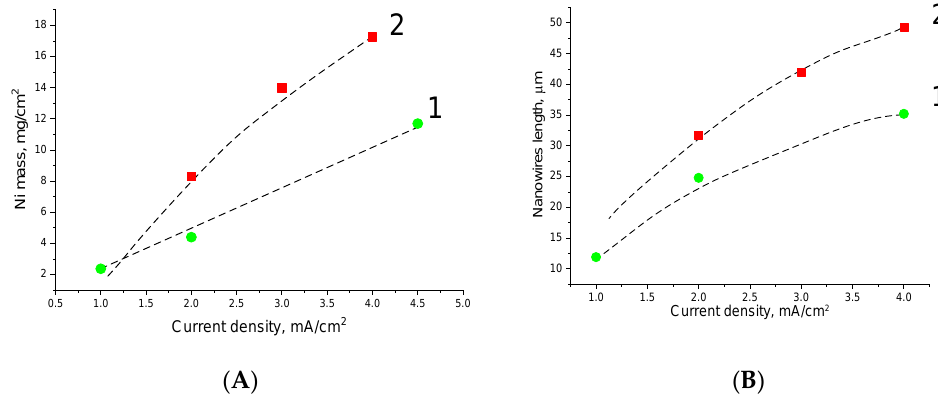
Figure 2. The dependences of the mass of the electrodeposited Ni ( A ) and the Ni NW length ( B ) on the current density at different deposition durations: 1—120 min; 2—240 min. Arrays of the compact Ni NWs with different aspect ratios in the MPAA of 55–75 µ m thicknesses at various current densities were obtained to refine and optimize the param- eters of the electrodeposition process. Figure 3 presents the SEM images of the Ni NW experimental samples synthesized in the MPAA with 55, 65 and 75 µ m thicknesses.